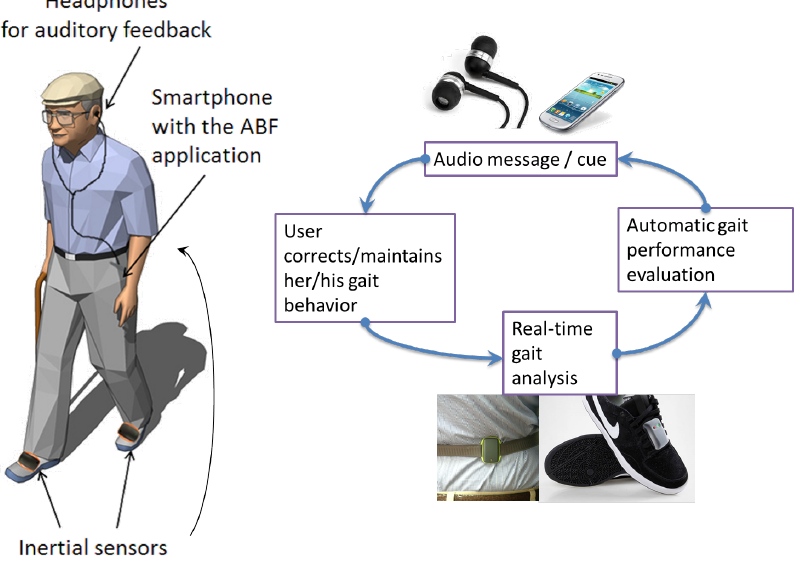
Figure 1. Scheme of the scenario for the use and the components of the